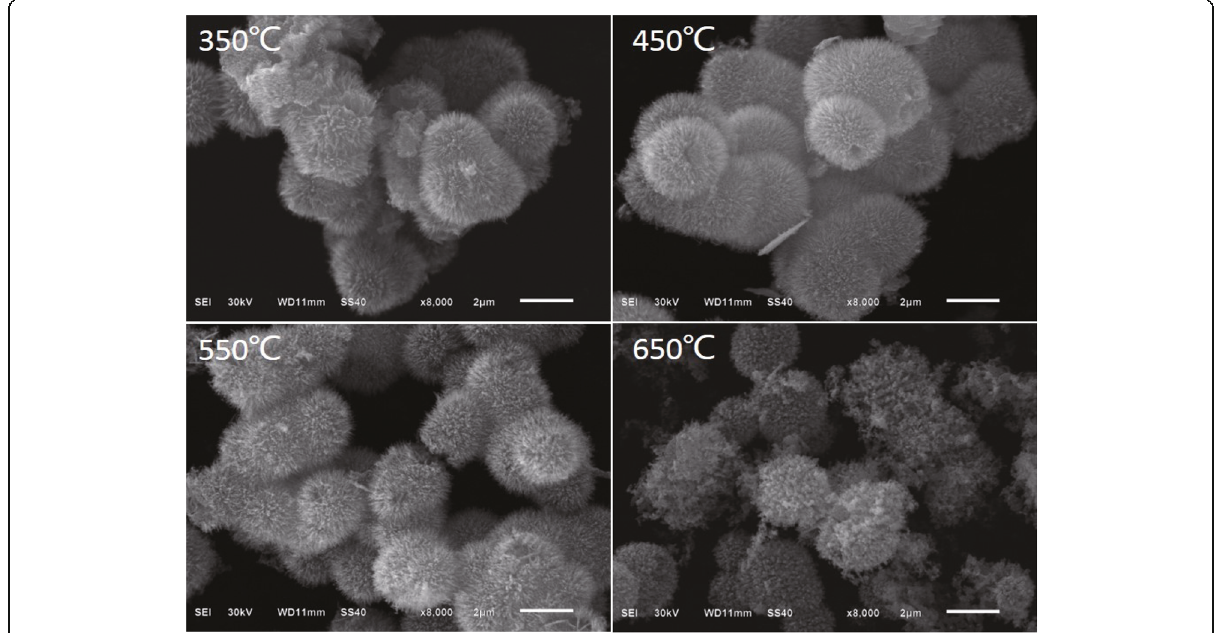
Fig. 2 SEM images of NiCo 2 O 4 particles and NiO/NiCo 2 O 4